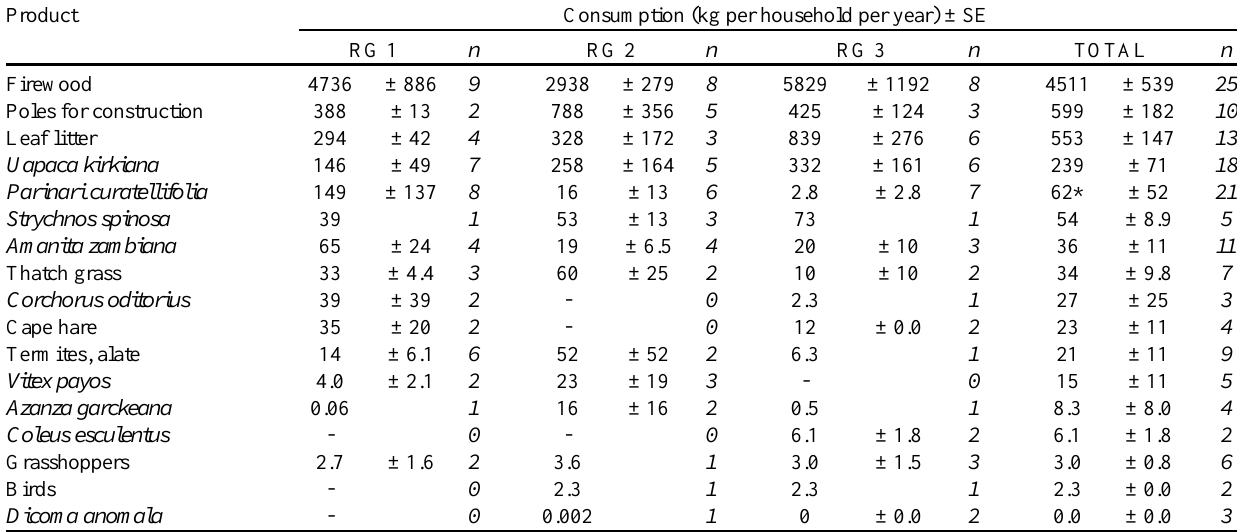
Table 3 . Mean consumed quantities of 17 key nontimber forest products for three resource groups (RG) in years of a) normal and b) poor rainfall. The asterisk* indicates a significant difference (a < 0.05) between the years (paired-sample